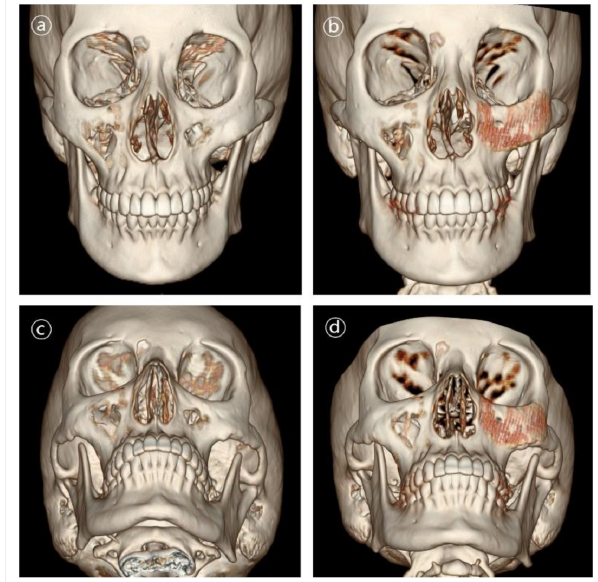
Figure 6. 3D CT images in patient #1. Contour and symmetry of left zygomatico-maxillary region was restored with de novo bone formation. ( a , b ) Pre- and postoperative 6-month frontal view CT images. ( c , d ) Pre- and postoperative 6-month basal view CT images.